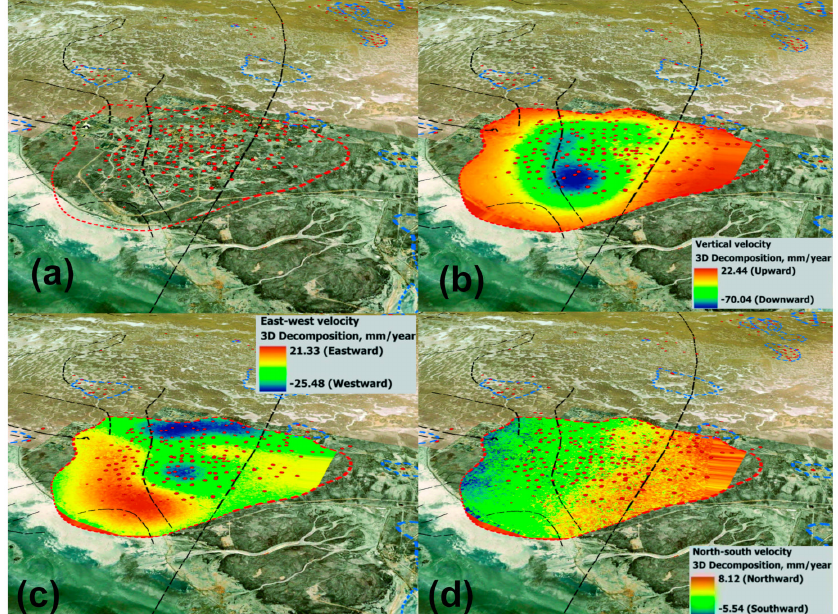
Figure 10. Oblique aerial view of: ( a ) Tengiz oilfield; ( b ) vertical deformation velocity derived from 3D decomposition; ( c ) east-west movement velocity derived from 3D decomposition; ( d ) north-west movement velocity from derived from 3D